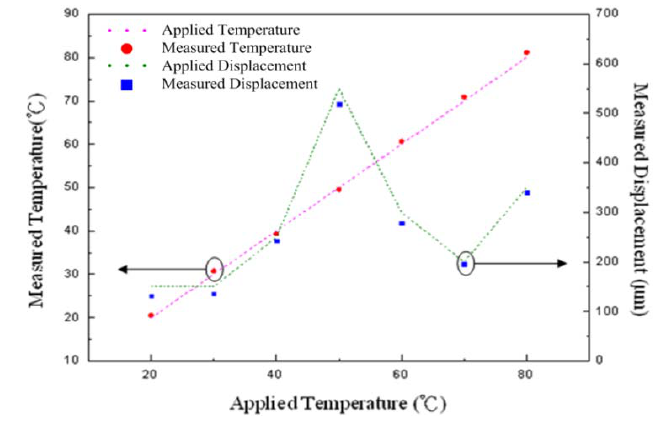
Figure 7. Comparison of actual displacement and temperature and measured displacement and temperature at various